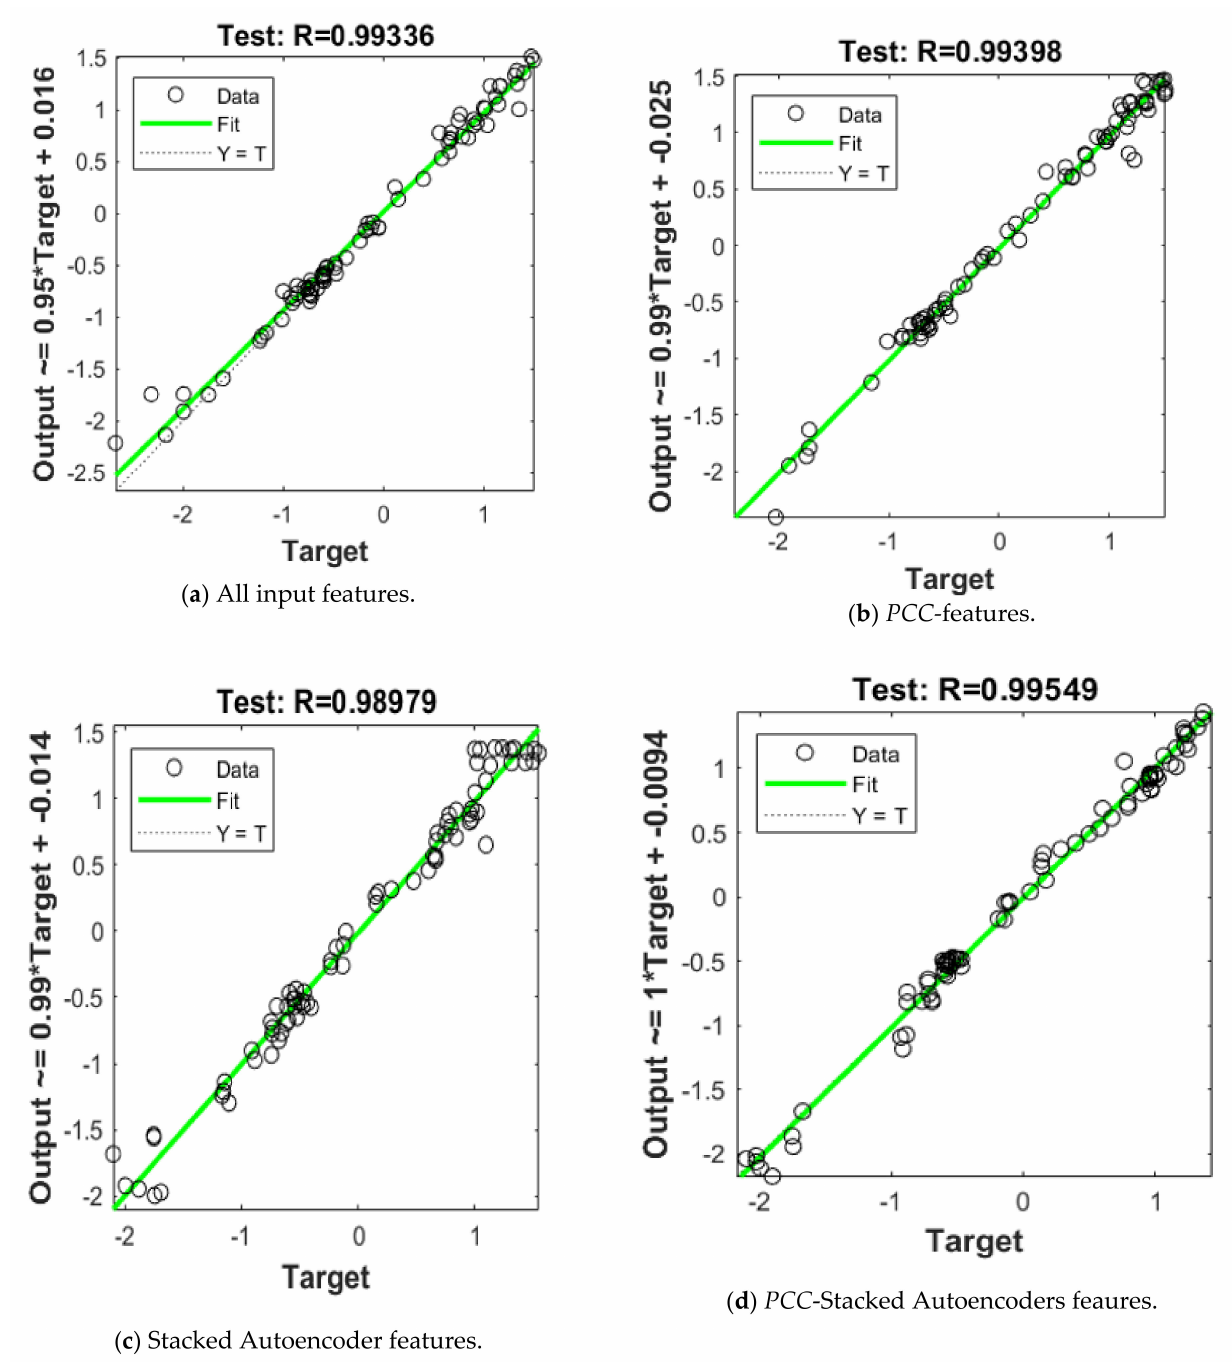
Figure 7. The fitting curve of the NN regression models trained using different sets of features for Oil